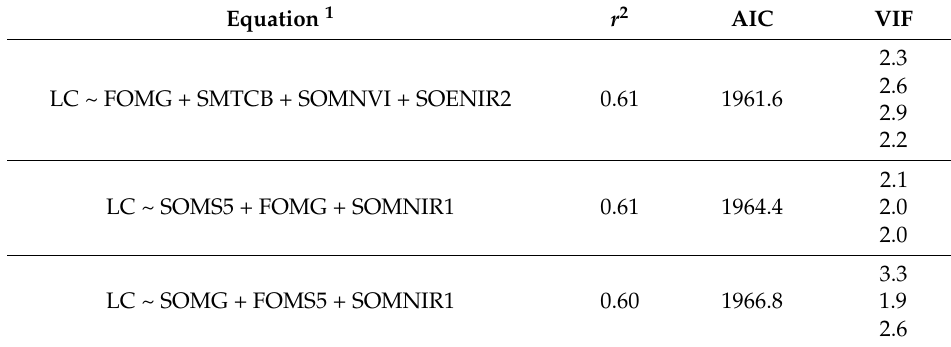
Table 4. Candidate models considered in the analysis of the relationship between LC and Landsat MSS